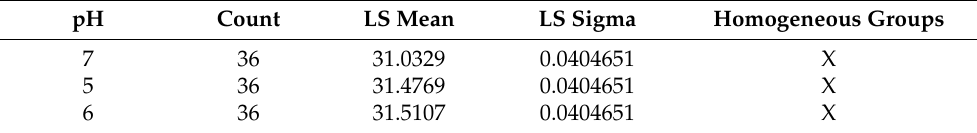
Table 3. Multiple range tests for N-AcG (mg/g) by